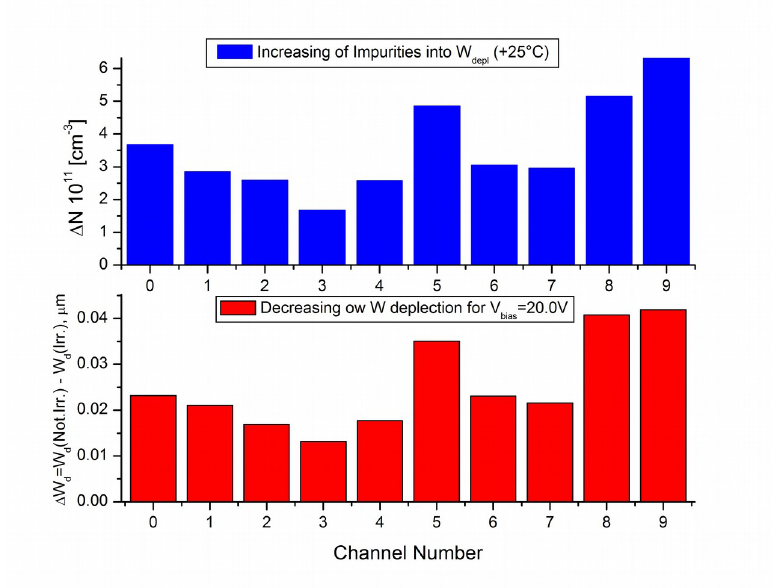
Figure 2. Increasing integral of concentration impurities (1) and decreasing depletion region for SiPM for irradiated